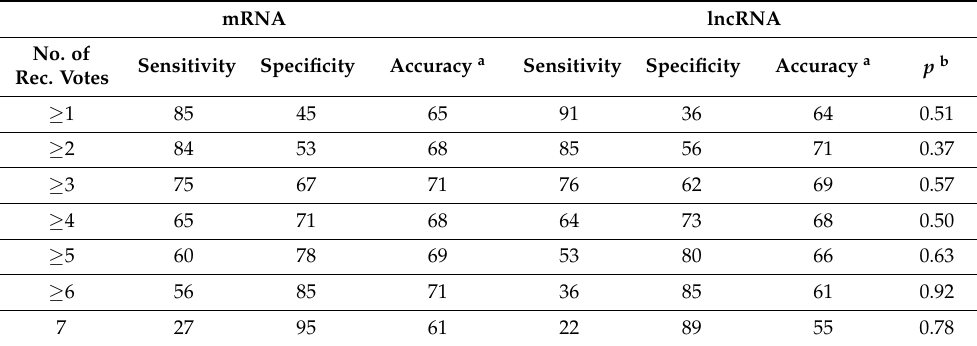
Table A4. Integrated voting results for ER positive BC patients following optimized balanced accuracy